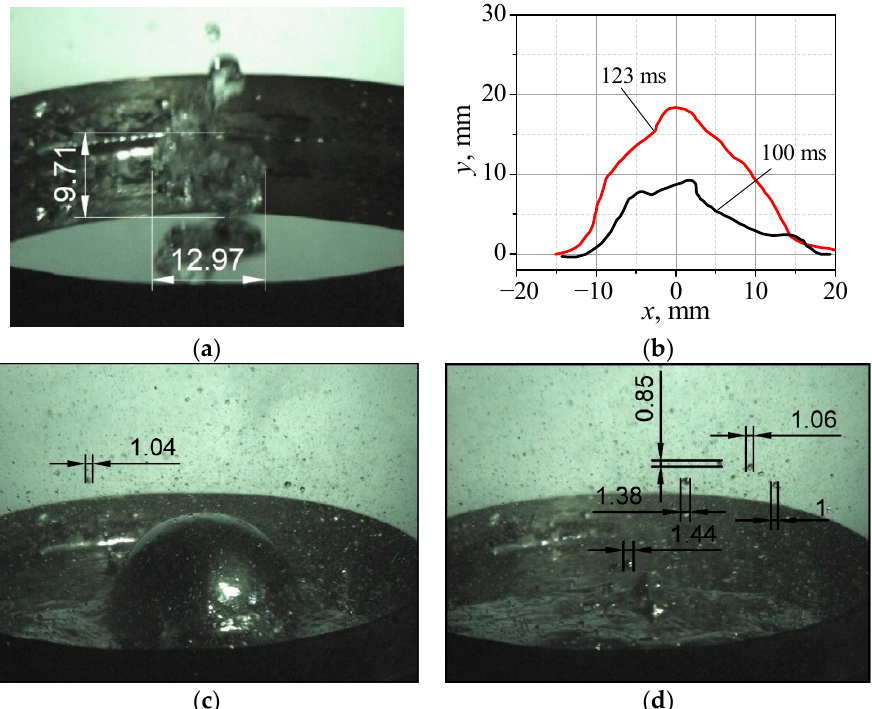
Figure 6. Melt–water jet interaction, Case J2: ( a ) pre-impact shape of water volume; ( b ) shape of the primary cumulative jet at different times; ( c ) floating bubble on the melt surface; ( d ) emergence of small “eruptions” ejecting melt droplets after collapse of the floating bubble.